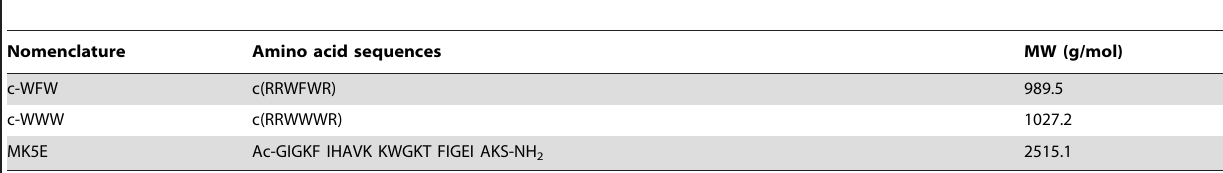
Table 1. Molecular weight (MW) and amino acid sequences of the cyclic (c) hexapeptides (c-WFW and c-WWW) and the magainin derivative